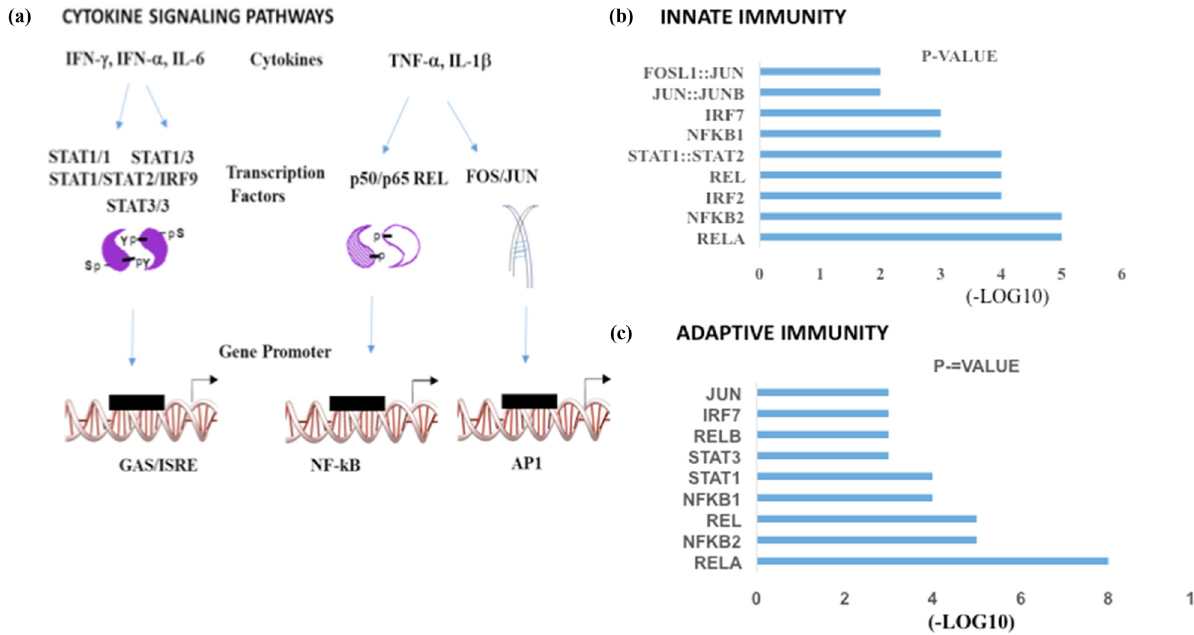
Figure 2: Cytokine signaling and transcription factor hubs critical for innate and adaptive immunity. ( a ) Schematic representation of cytokines and transcription factors associated with innate and adaptive immunity. ( b ) Transcription factors in the promoter region ( − 1,000 to + 1 ) of genes involved in the regulation of innate immunity in mouse macrophage RAW 264.7 cells by TLR ligands are ranked by signi fi cance. ( c ) Transcription factors in the promoter region ( − 1,000 to + 1 ) of genes involved in the regulation of adaptive immunity in mouse lung type II cells by CD8 + T cell recognition are ranked by signi fi